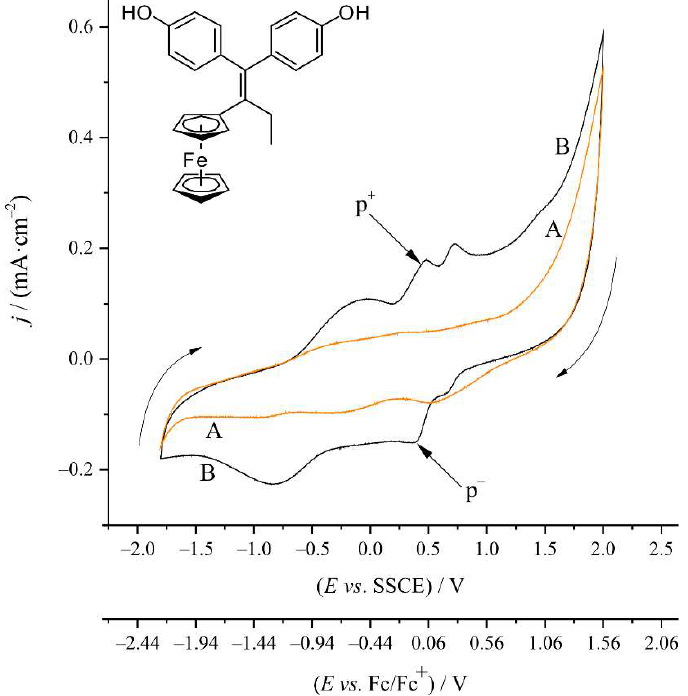
Figure 2. Cyclic voltammograms recorded at Pt (surface area A = 8.1 mm 2 ) in contact with (A) 0.1 M Bu 4 NClO 4 in MeCN (blank solution (orange curve)) (B) 0.1 M Bu 4 NClO 4 + 1 mM 43 in MeCN. Scan rate: v = 1 V/s.